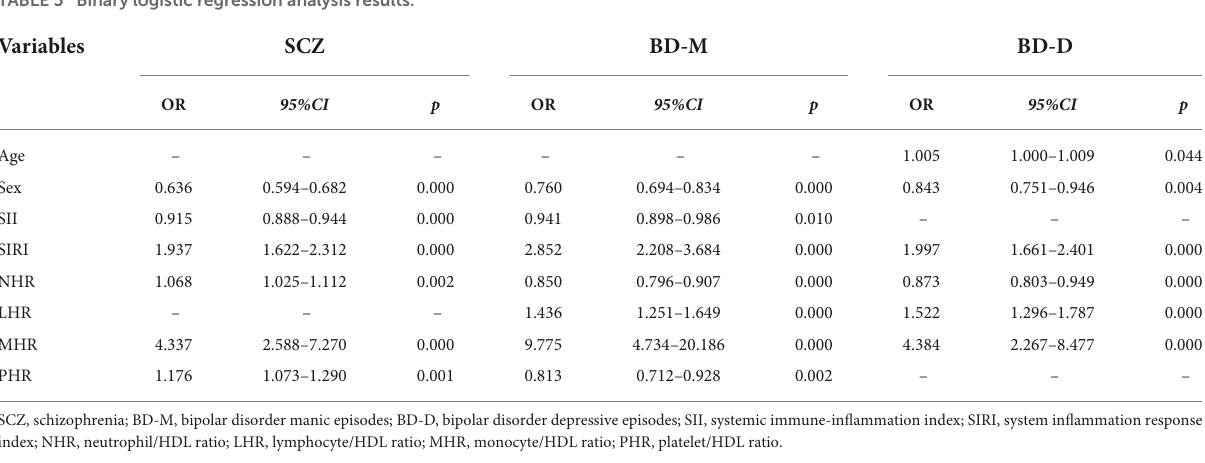
TABLE 5 Binary logistic regression analysis results.